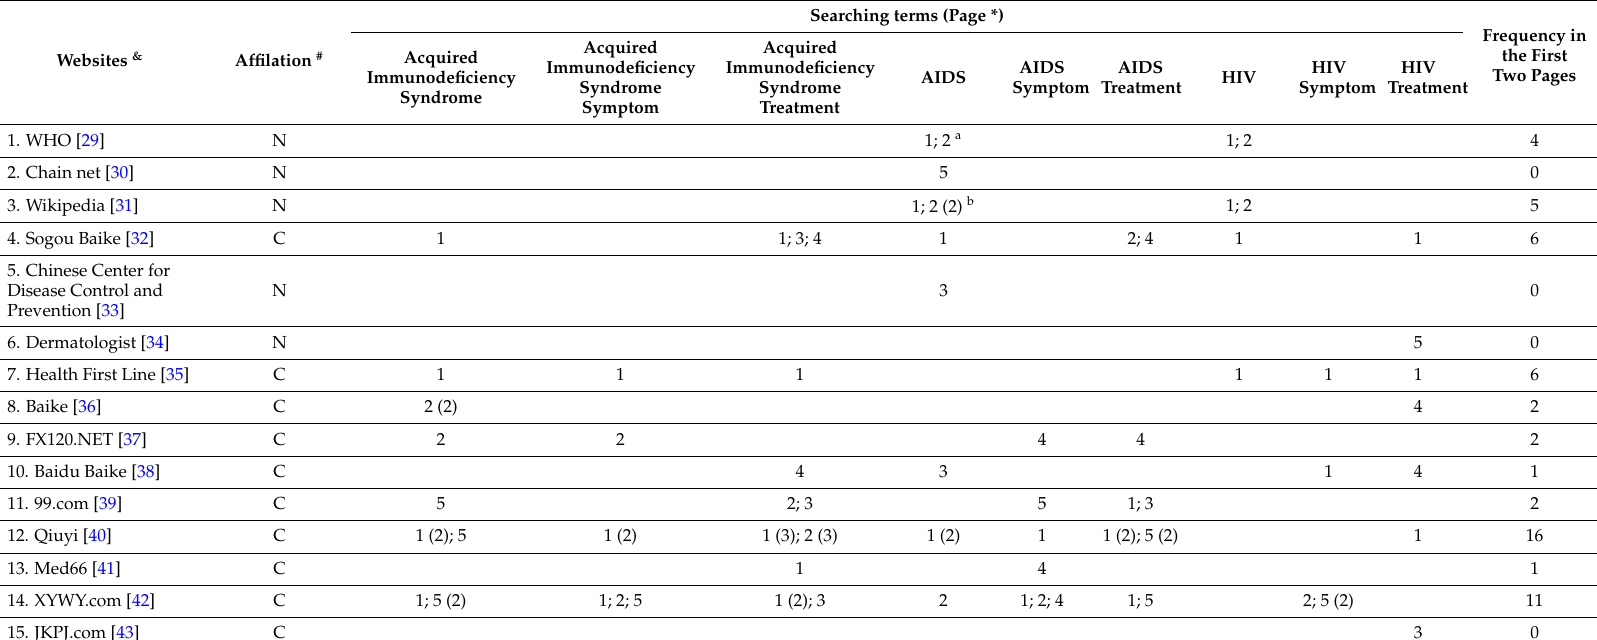
Table 3. The searching results of the top 15 websites obtain from Sogou by each